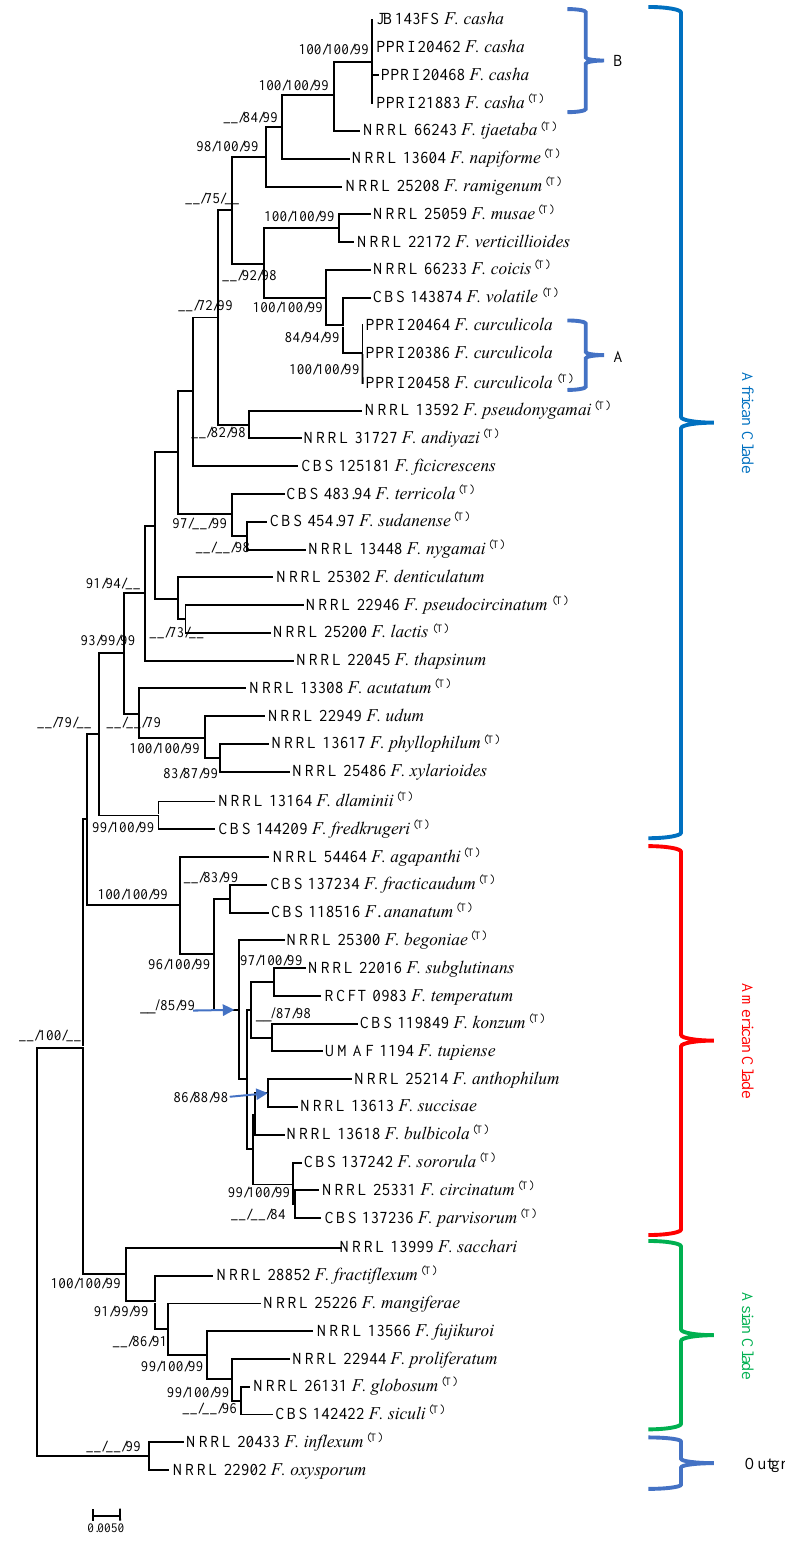
Figure 1. Phylogram obtained from maximum likelihood analyses for combined TEF1 α , ßT and RPB2 gene sequences, obtained using the TIM2ef + G parameter model. For all trees, confidence levels >70% (1000-replicate bootstrap analysis) of the tree branch nodes, determined by ML and MP, and posterior probabilities for Bayesian inference (BI) are indicated on tree branches (ML/MP/BI). Fusarium inflexum and F. oxysporum are defined as the outgroup taxa.